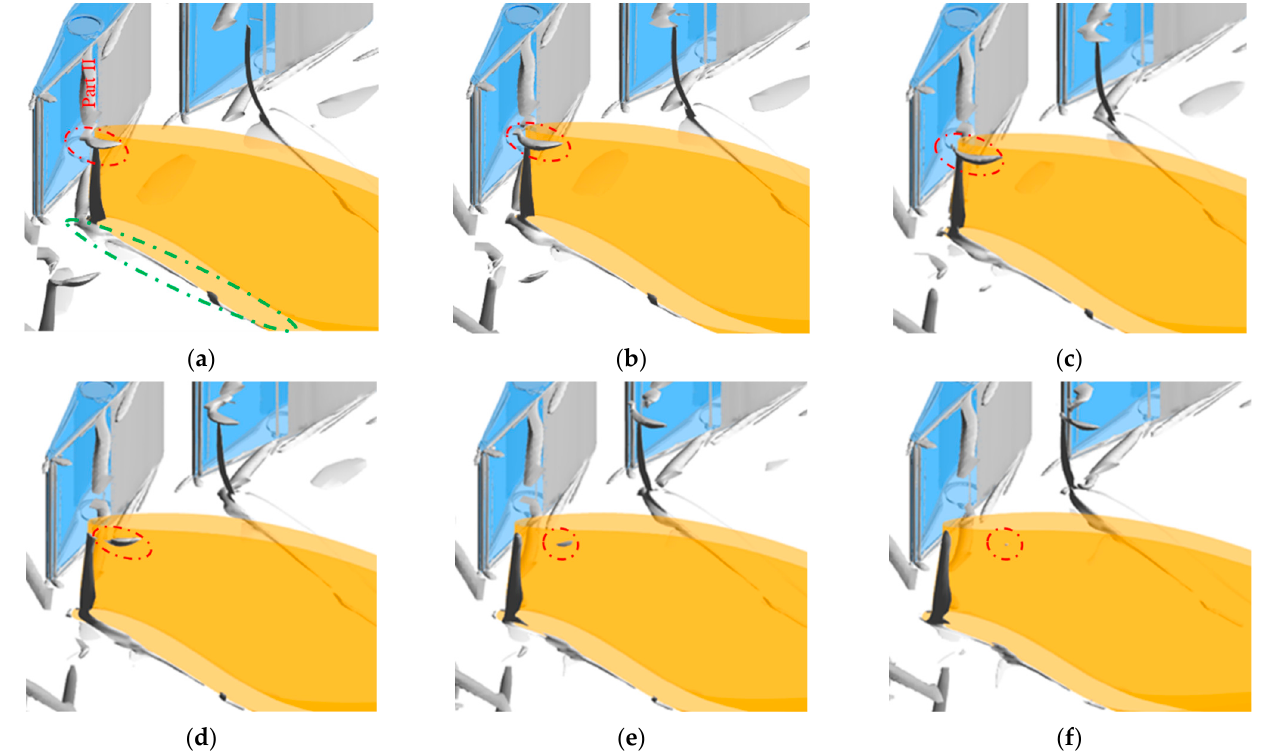
Figure 11. Progression of leakage vortex during runner rotation at BEP: ( a ) T 0 ; ( b ) T 0 + 1/5 of X°; ( c ) T 0 + 2/5 of X°; ( d ) T 0 + 3/5 of X°; ( e ) T 0 + 4/5 of X°; ( f ) T 0 + X°.